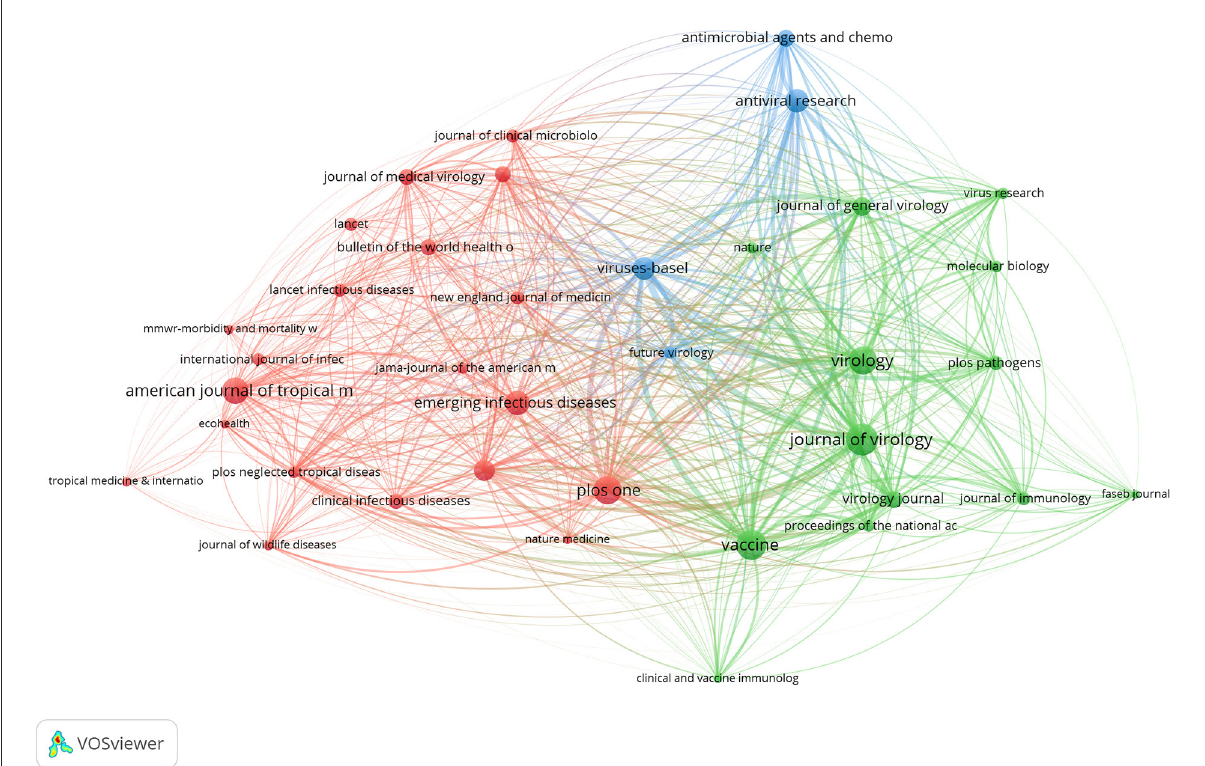
FIGURE11 Bibliographic coupling of sources in monkeypox research. Different colors indicated different research areas, the size of the circles indicated the number of co-citations, and the distance relationship between the two circles indicated their